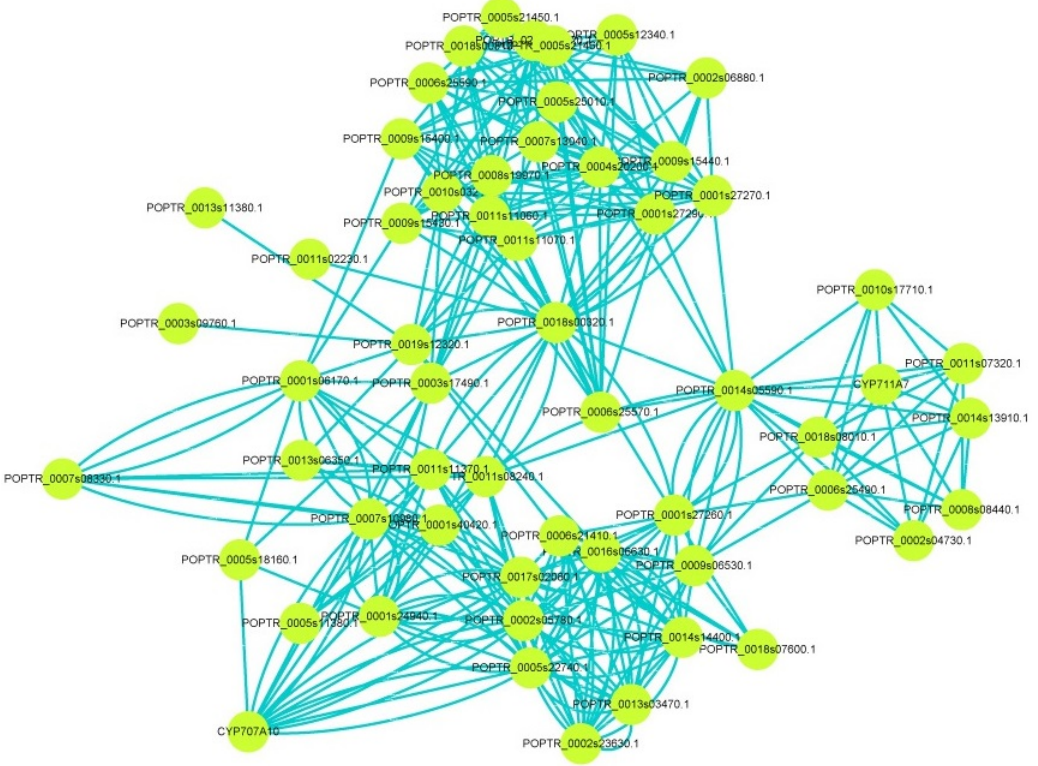
Figure 6. The interaction network for PtCCD members in poplar. The String database (https://string-db.org/ (accessed on 28 July 2021)) was used to predict the interaction relationship between PtCCD members and other proteins, and Cytoscape software was applied to visualize the interaction network.